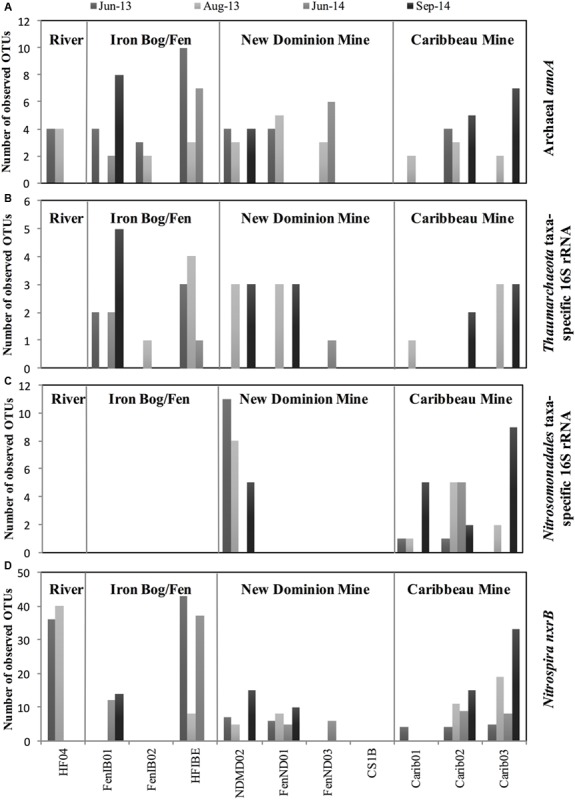
Number of observed OTUs at each site across 2013 and 2014 for (A) Archaeal amoA, (B)
Thaumarchaeota taxa-specific 16S rRNA, (C)
Nitrosomonadales taxa-specific 16S rRNA, and (D)
Nitrospira nxrB genes. Samples not sequenced were: HF04-June14; HF04-Sept14; FenND03-Jun13; FenND03-Sept14; FenIB02-Sept14; Carib01-June14. All other samples with zero values did not amplify.